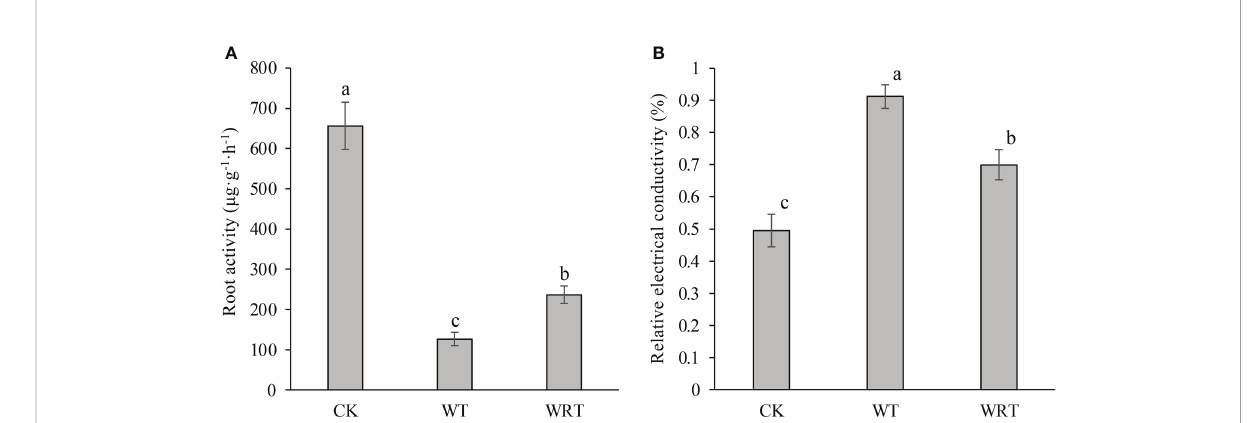
FIGURE 2 Physiological changes of the control (CK), waterlogging treatment (WT), and waterlogging recovery treatment (WRT) of P. ostii. (A) , Root activity; (B) , Relative electrical conductivity of root. Values represent mean ± standard deviation (SD), and letters indicate signi fi cant differences according to Duncan ’ s multiple range test ( p <